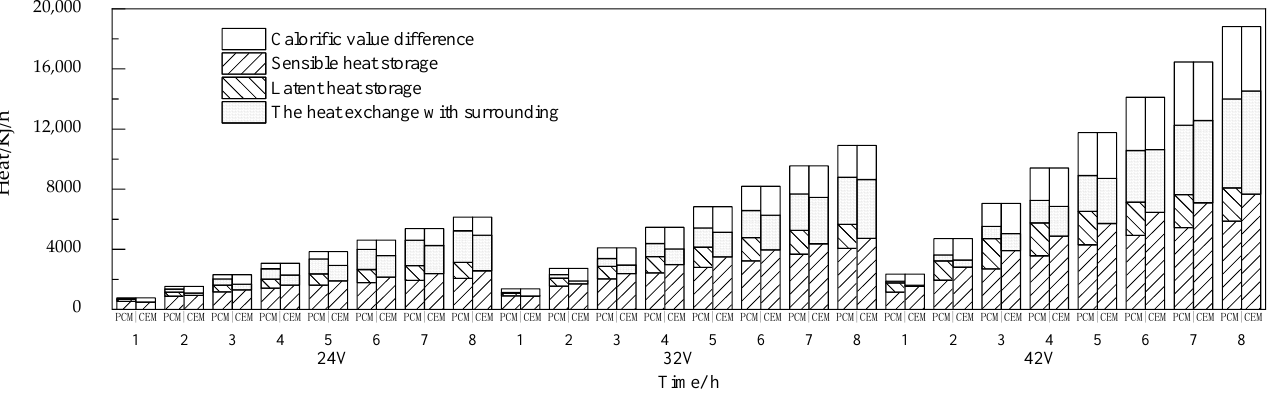
Figure 16. Variation in heat storage of the wallboards with time.